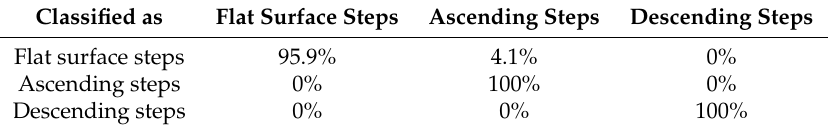
Table 5. Confusion matrix for detecting steps walking on flat surfaces, ascending stairs and descending